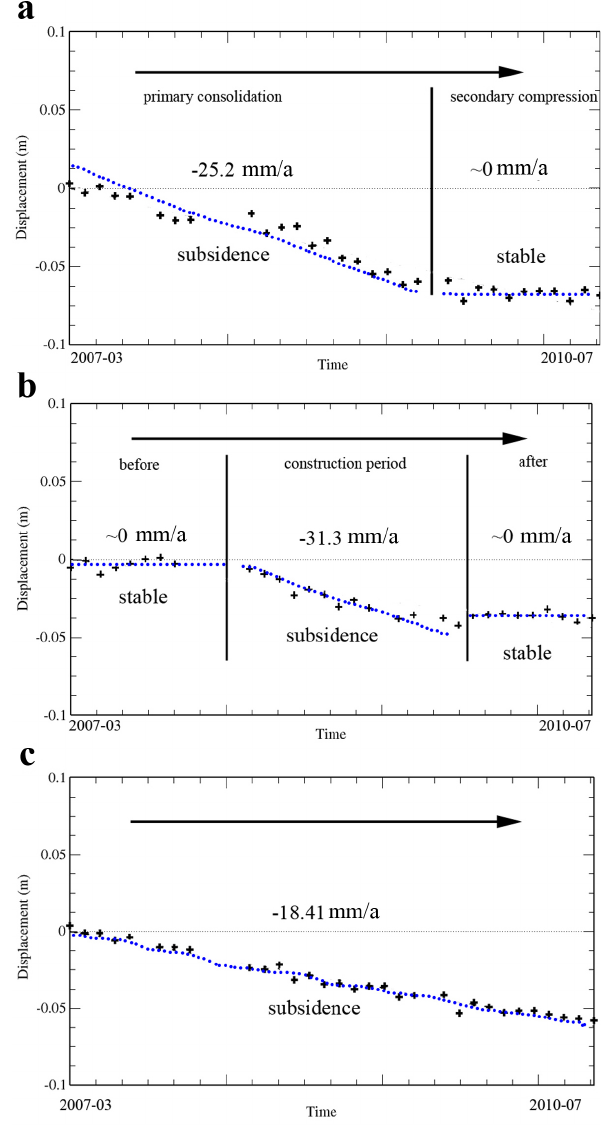
Fig. 5. Driving force discrimination conducted by the comparison between PS displacement time series and geological deformation modes; (a) a reclamation mode, the subsidence rate can reach as high as − 25.2mma − 1 during the primary consolidation compared with approximately zero in the secondary compression stage; (b) an infrastructure construction mode, the historical displacements are cascaded, demonstrating close relationship with the construction period; (c) a groundwater overexploitation mode, the surface sub- sidence is ongoing with an average rate of − 18.41mma − 1 during the whole observation